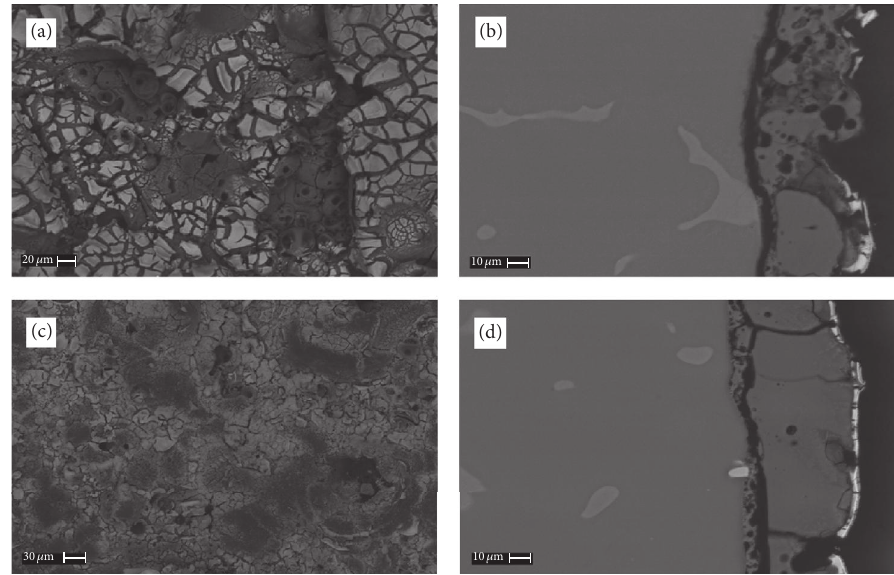
Figure 8: Scanning electron micrographs (backscattered electrons) of the surface and cross section of sealing coatings formed on AZ91 magnesium alloy with 12 g/l of La(NO 3 ) 3 at 30 ∘ C for 10 minutes (a-b) and 30 minutes (c-d).